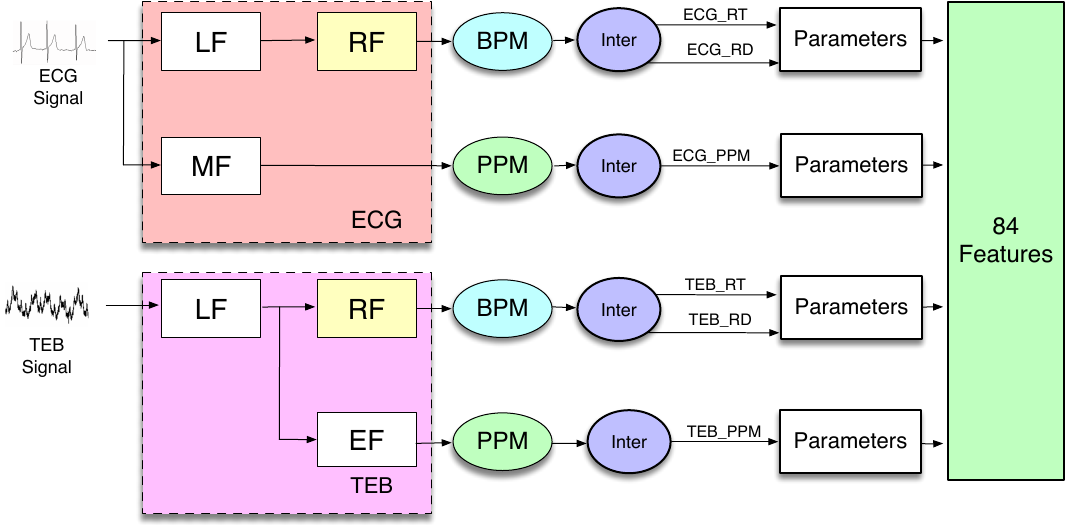
Figure 3. Feature extraction